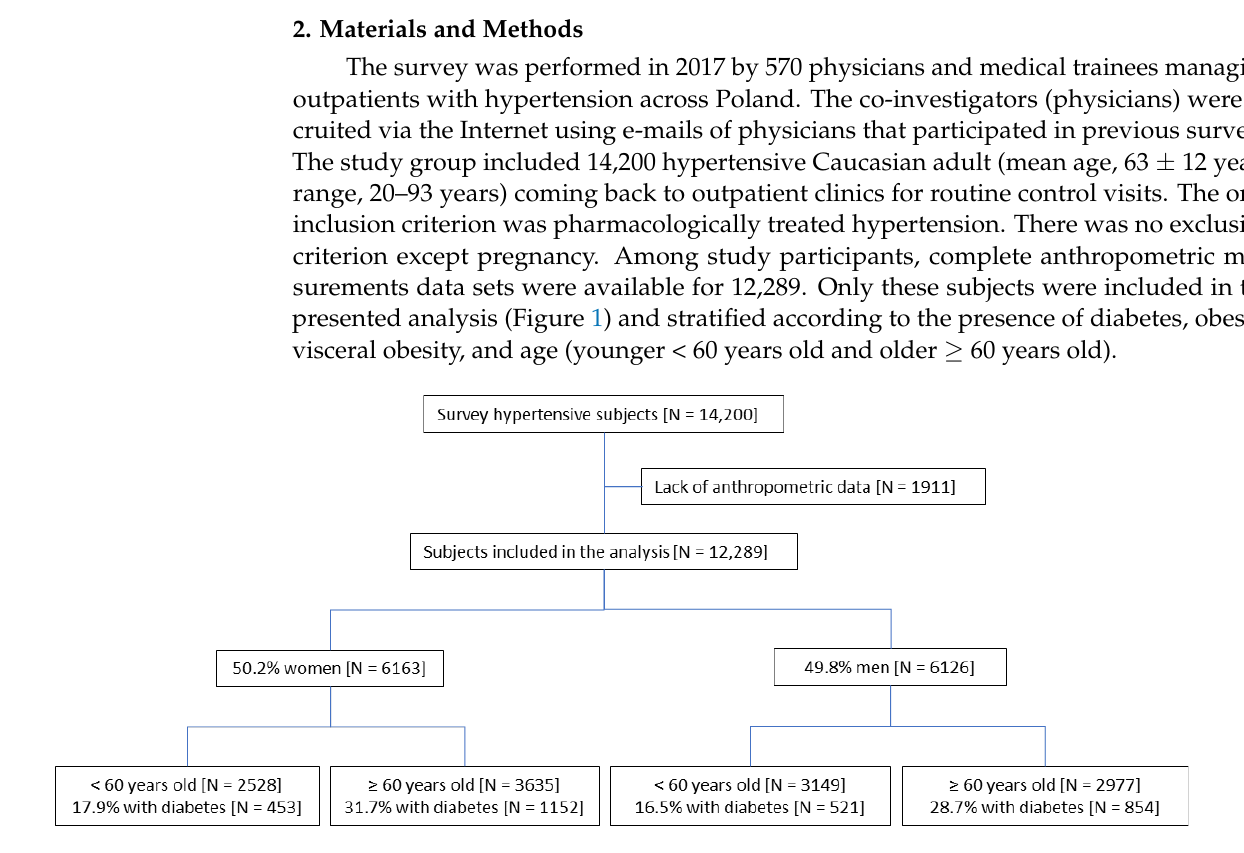
Figure 1. The analysis flow chart.